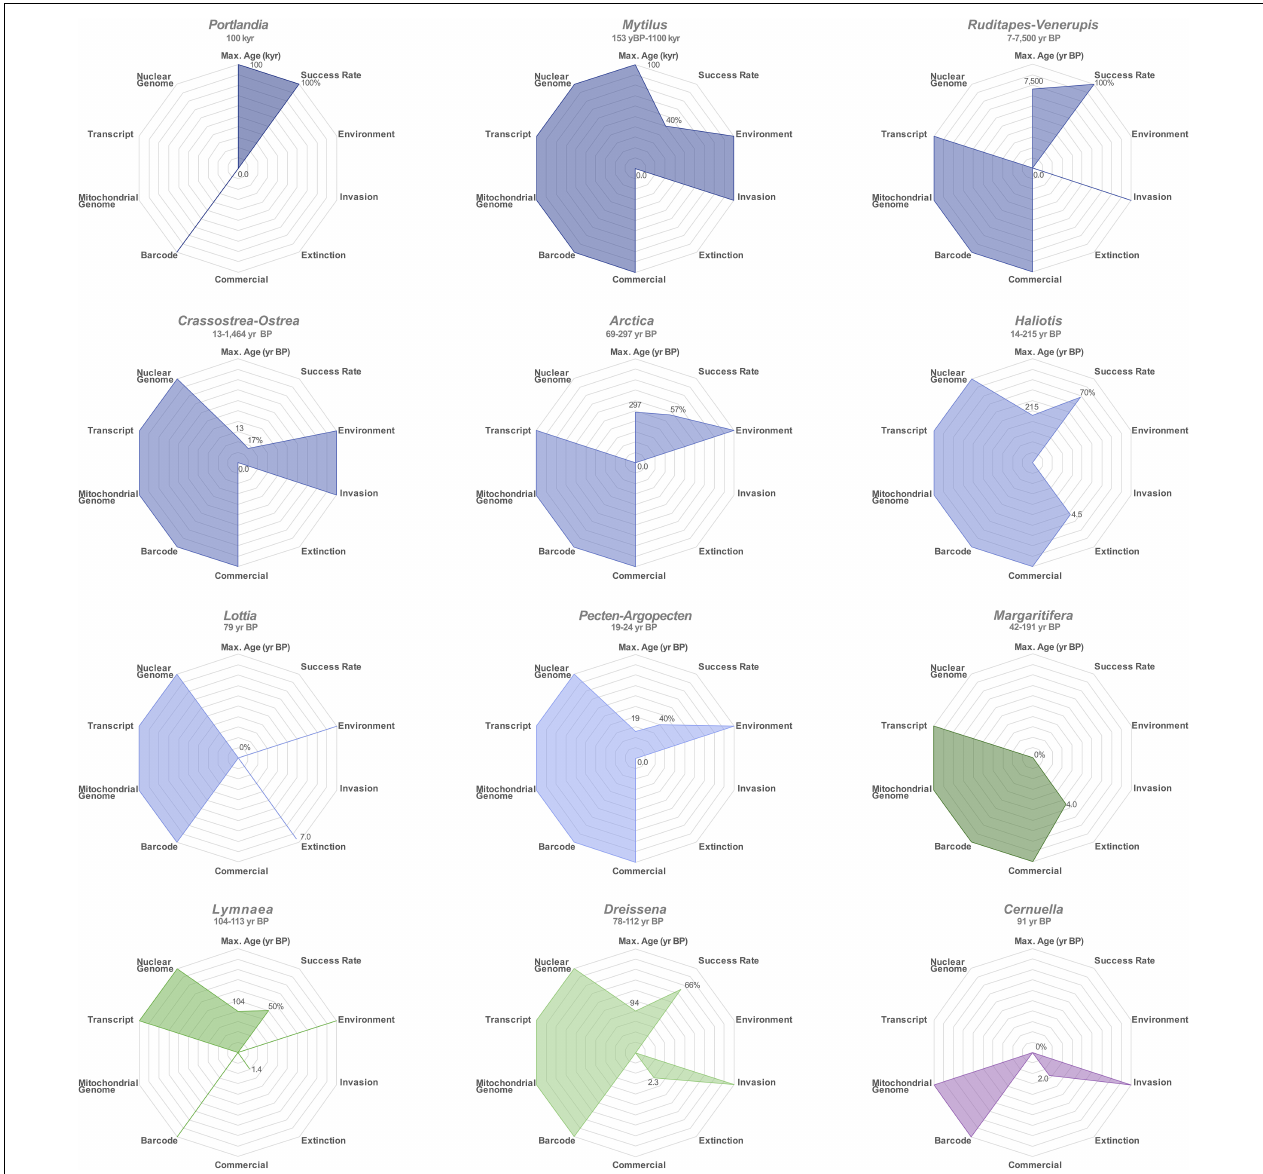
FIGURE 6 | Radar plot summarizing application potential of ancient shell DNA for mollusk genera. Marine genera are represented in blue shades, freshwater genera in green shades and the terrestrial genus Cernuella in purple. “Max. Age” refers the age of the oldest sample for which DNA could successfully be recovered; “kyr,” kilo years; “year BP,” years Before